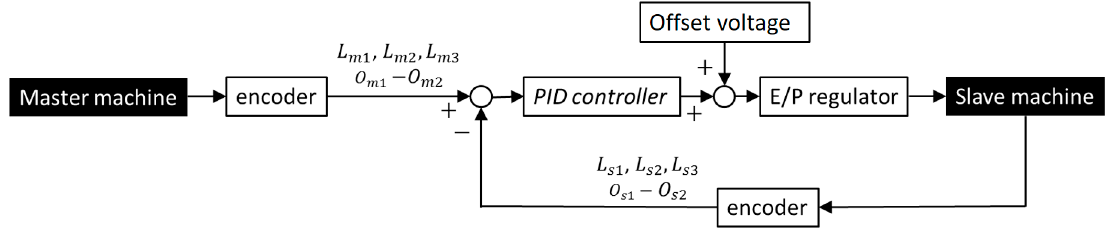
Figure 11. Block diagram of the master-slave control system.